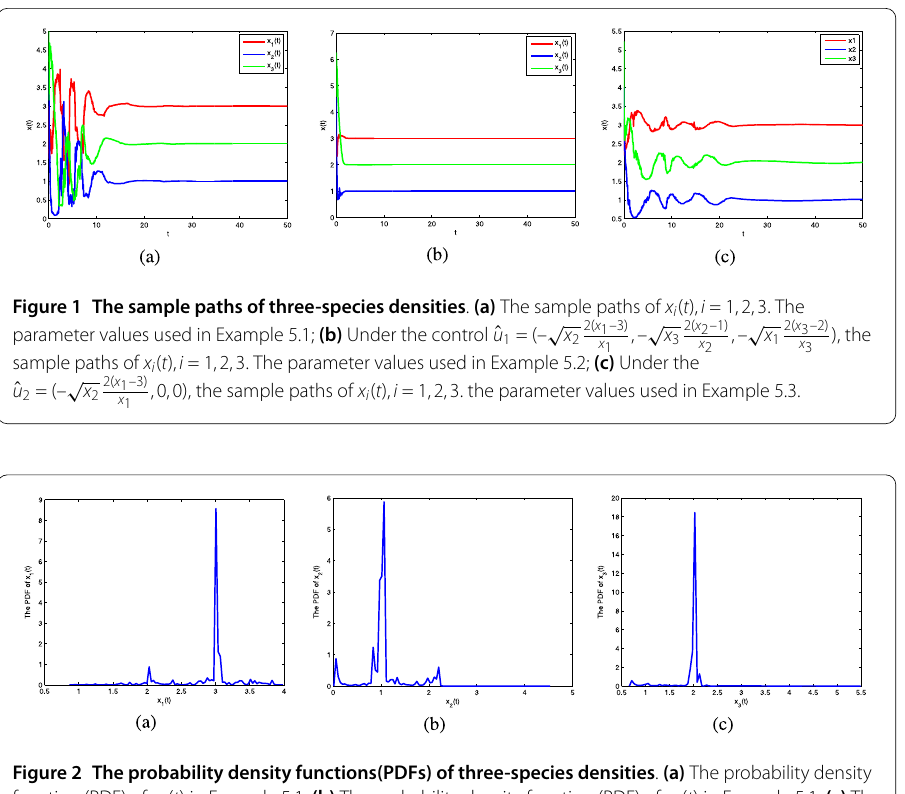
Figure 2 The probability density functions(PDFs) of three-species densities . (a) The probability density function (PDF) of x 1 ( t ) in Example 5.1; (b) The probability density function (PDF) of x 2 ( t ) in Example 5.1; (c) The probability density function (PDF) of x 3 ( t ) in Example